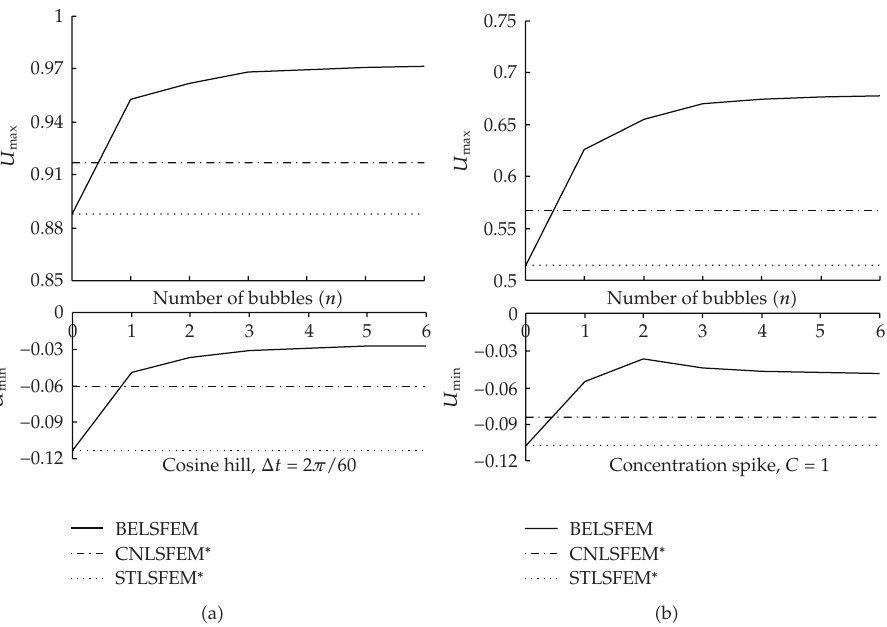
Figure 9: E ff ect of number of bubbles on the performance of BELFEM. (cid:3) ∗ pure LS method-results (cid:3) not functions of n (cid:4)(cid:4)